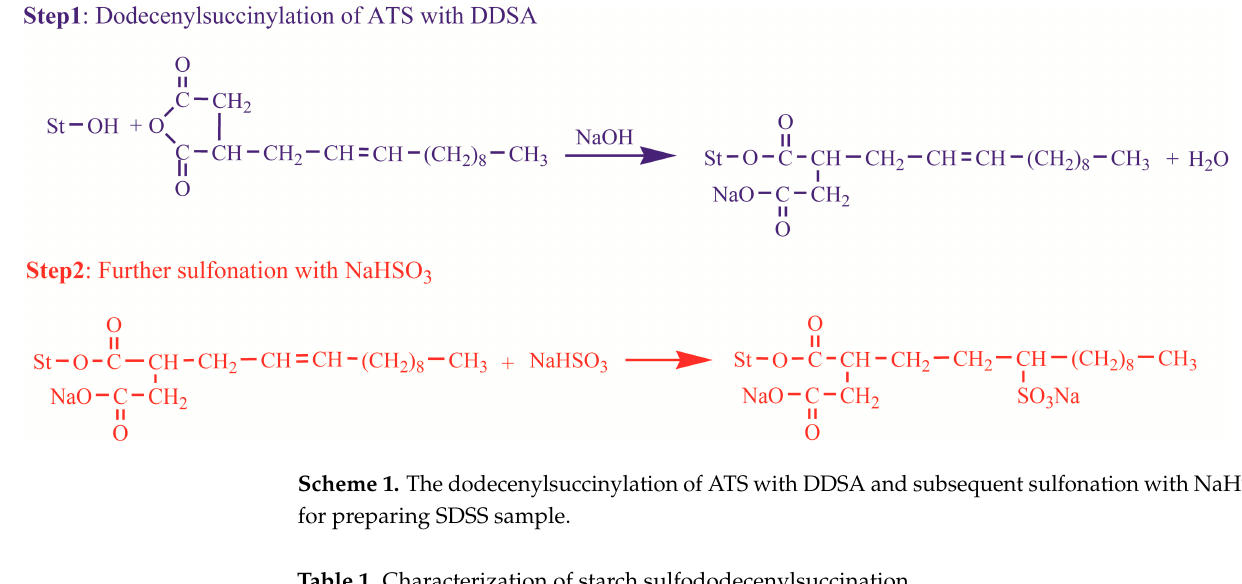
Table 1. Characterization of starch